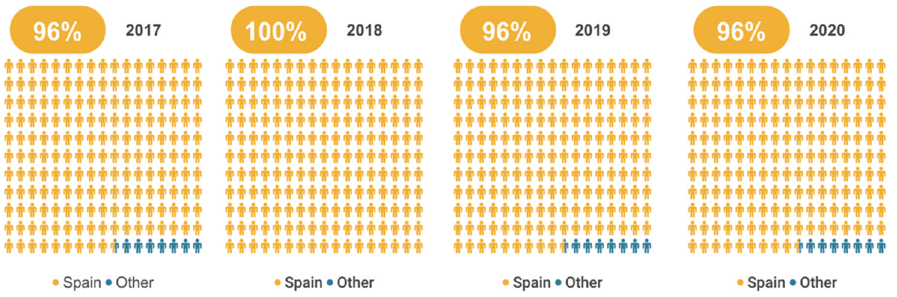
Figure 6. Percentages of Spanish accounts or those from other countries that the sample of Spanish deputies started to follow in 2017, 2018, 2019 and 2020.